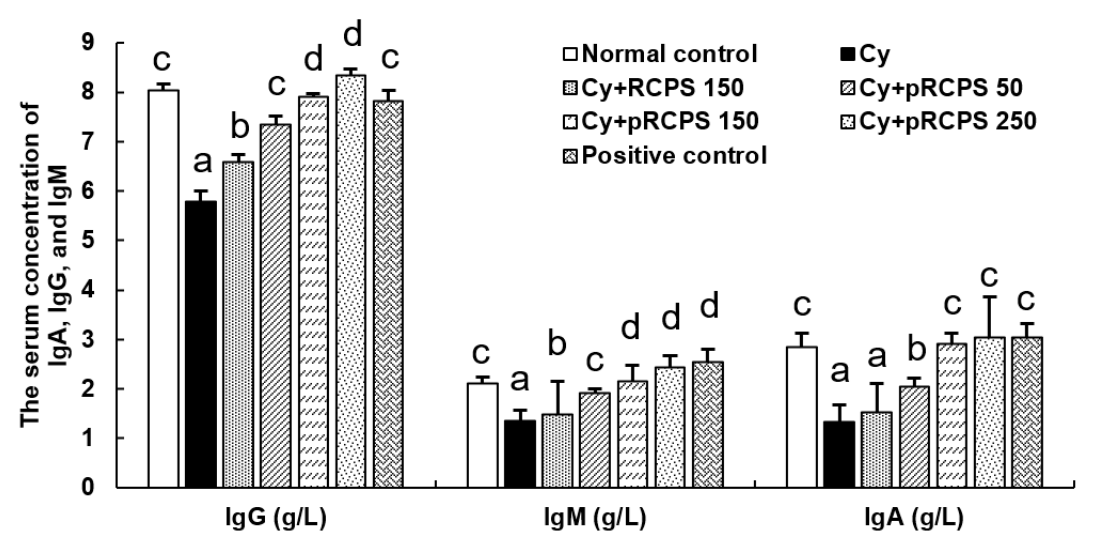
Figure 6. E ff ects of pRCPS on IgA, IgG, and IgM serum concentrations in Cy-immunosuppressed mice. After 24 h of the last treatment, serum samples were collected and the IgA, IgG, and IgM were determined by ELISA. Results are presented as the mean ± SD ( n = 10). Bars marked with di ff erent letters indicate di ff erences that are statistically significant ( p < 0.05).